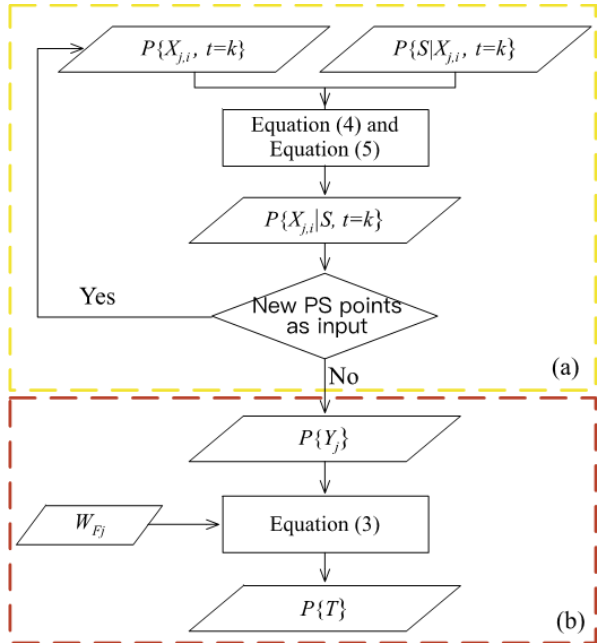
Figure 3. Flowchart to infer (a) the subsidence hazard probability of a single factor and (b) the subsidence hazard probability influenced by multiple